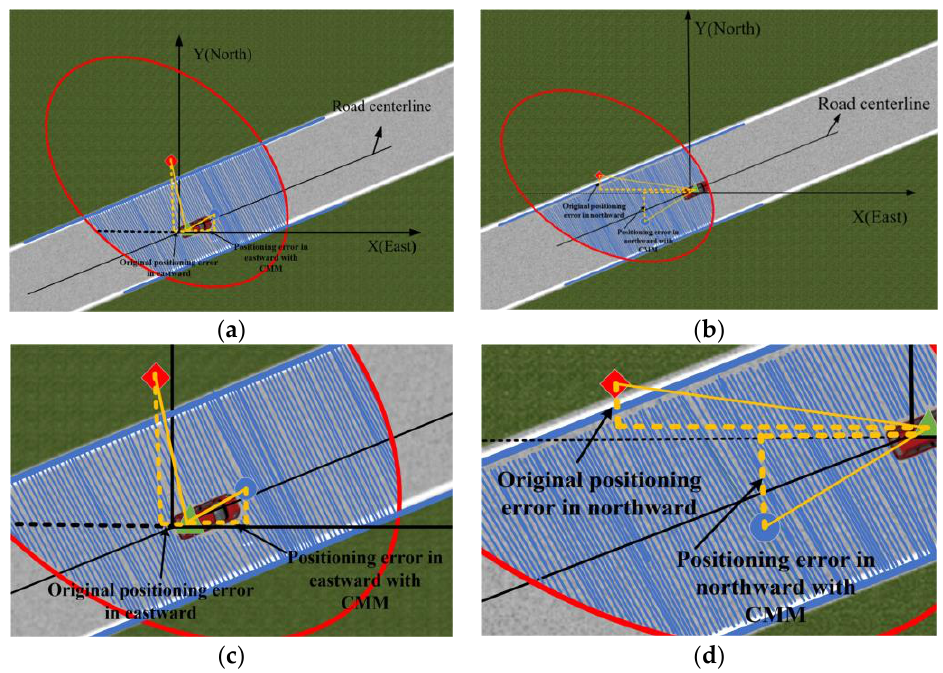
Figure 3. The principle of road constraints model. ( a ) Increase in eastward error; ( b ) increase in northward error; ( c ) expanded graph of ( a ); ( d ) expanded graph of ( b ).